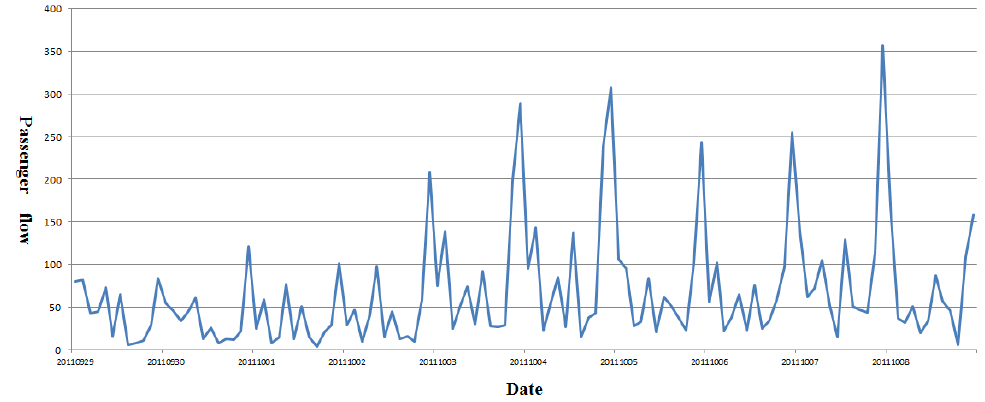
Figure 2. Change trend of passenger